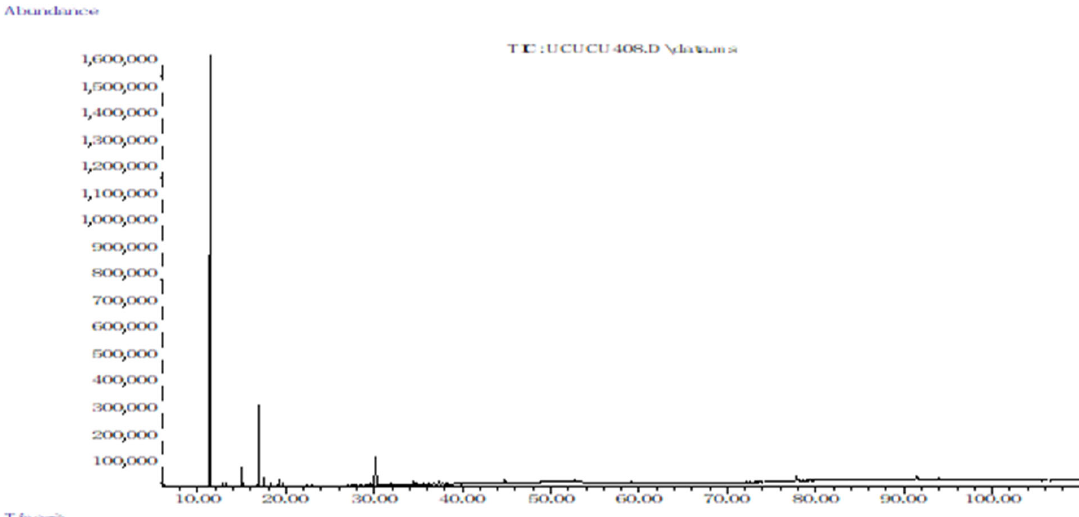
Figure 1. Total ion chromatogram of essential oil from fruit of Chamaecyparis obtusa.